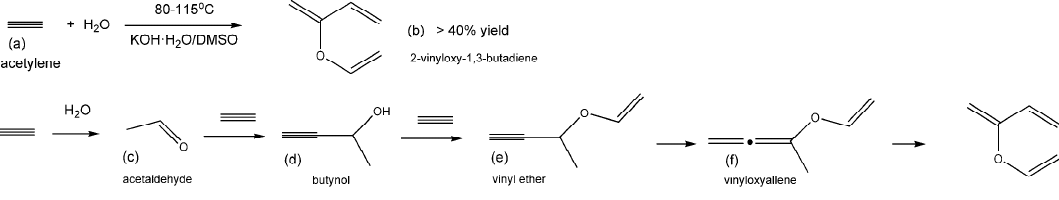
Figure 10. The pathway of synthesis of 2-vinyloxy-1,3-butadiene [130–132].